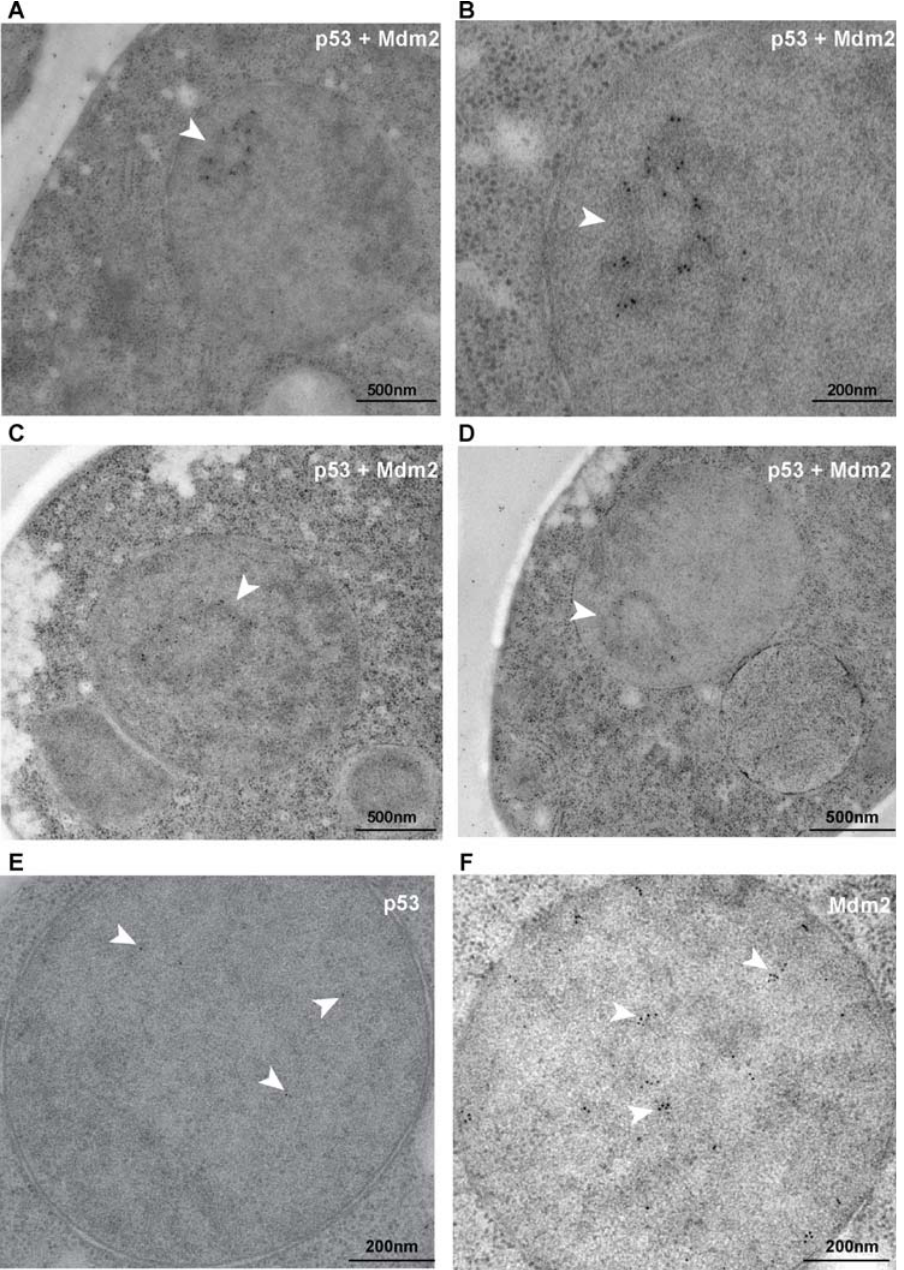
Figure 4. p53-Mdm2 complexes localize to yeast nuclear bodies morphologically akin to human PML bodies . Immunogold labeling against p53 (A,D,E) or Mdm2 (C,F) of thin sections of yeast cells expressing the indicated proteins. Total number of cells analyzed for each case: 10. (B) Magnification of the p53-Mdm2 body (arrowhead) in the cell in panel A.